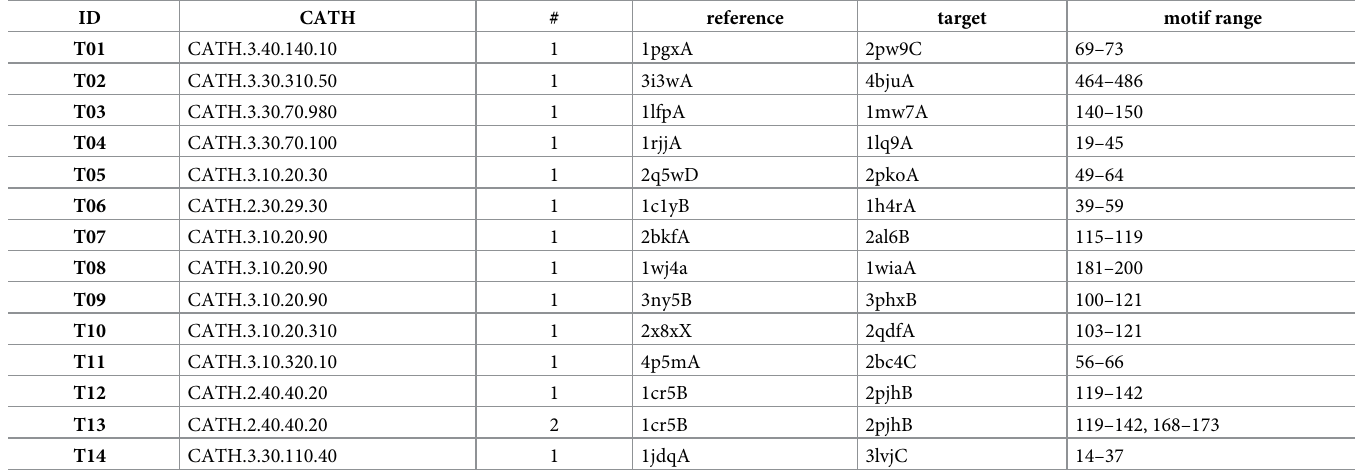
Table 1. Targets included in the conformational and sequence recovery benchmark. For each of the benchmark targets is indicated the CATH superfamily and repre- sentatives used in the simulations. (#) indicates the number of segments in the target protein that are considered motif. Motif range indicates the residues considered motif according to the PDB